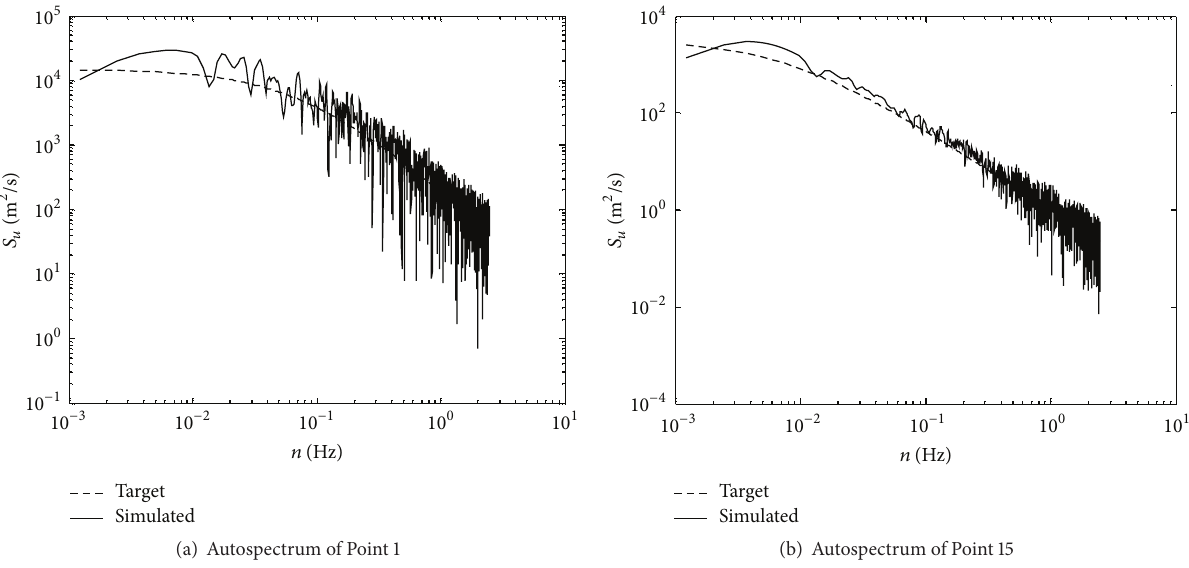
Figure 8: Autospectra of longitudinal fluctuating wind velocities at bridge tower number 3.